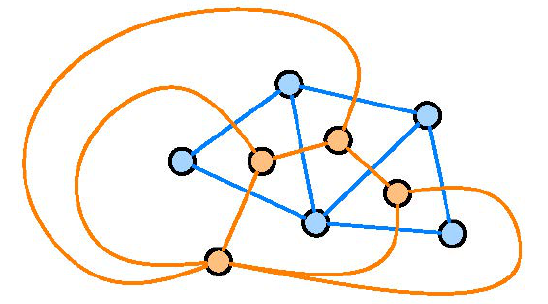
Figure 49: The orange graph is the dual graph of the blue